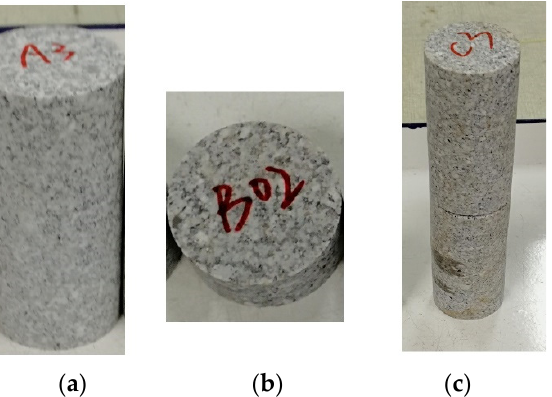
Figure 2. Experimental samples: ( a ) Uniaxial compression test sample. ( b ) Brazilian splitting test sample. ( c ) Three-point bending test sample.